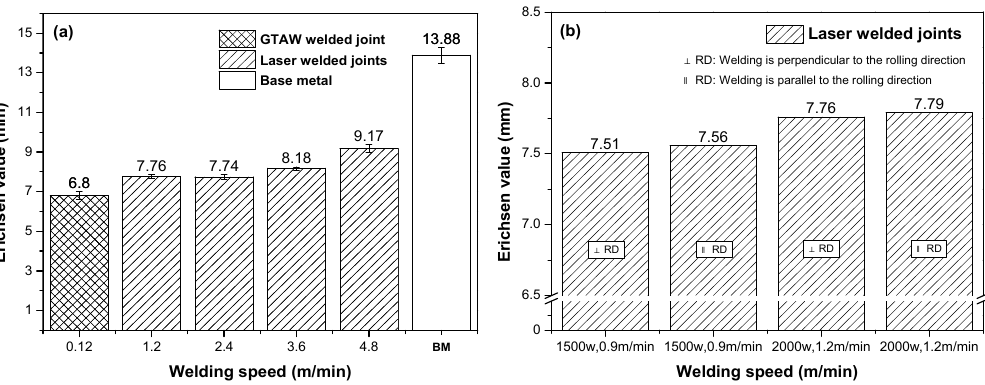
Figure 9. Erichsen cupping values of ( a ) welded joints with di ff erent welding speed and BM; ( b ) welded joints with di ff erent welding directions.